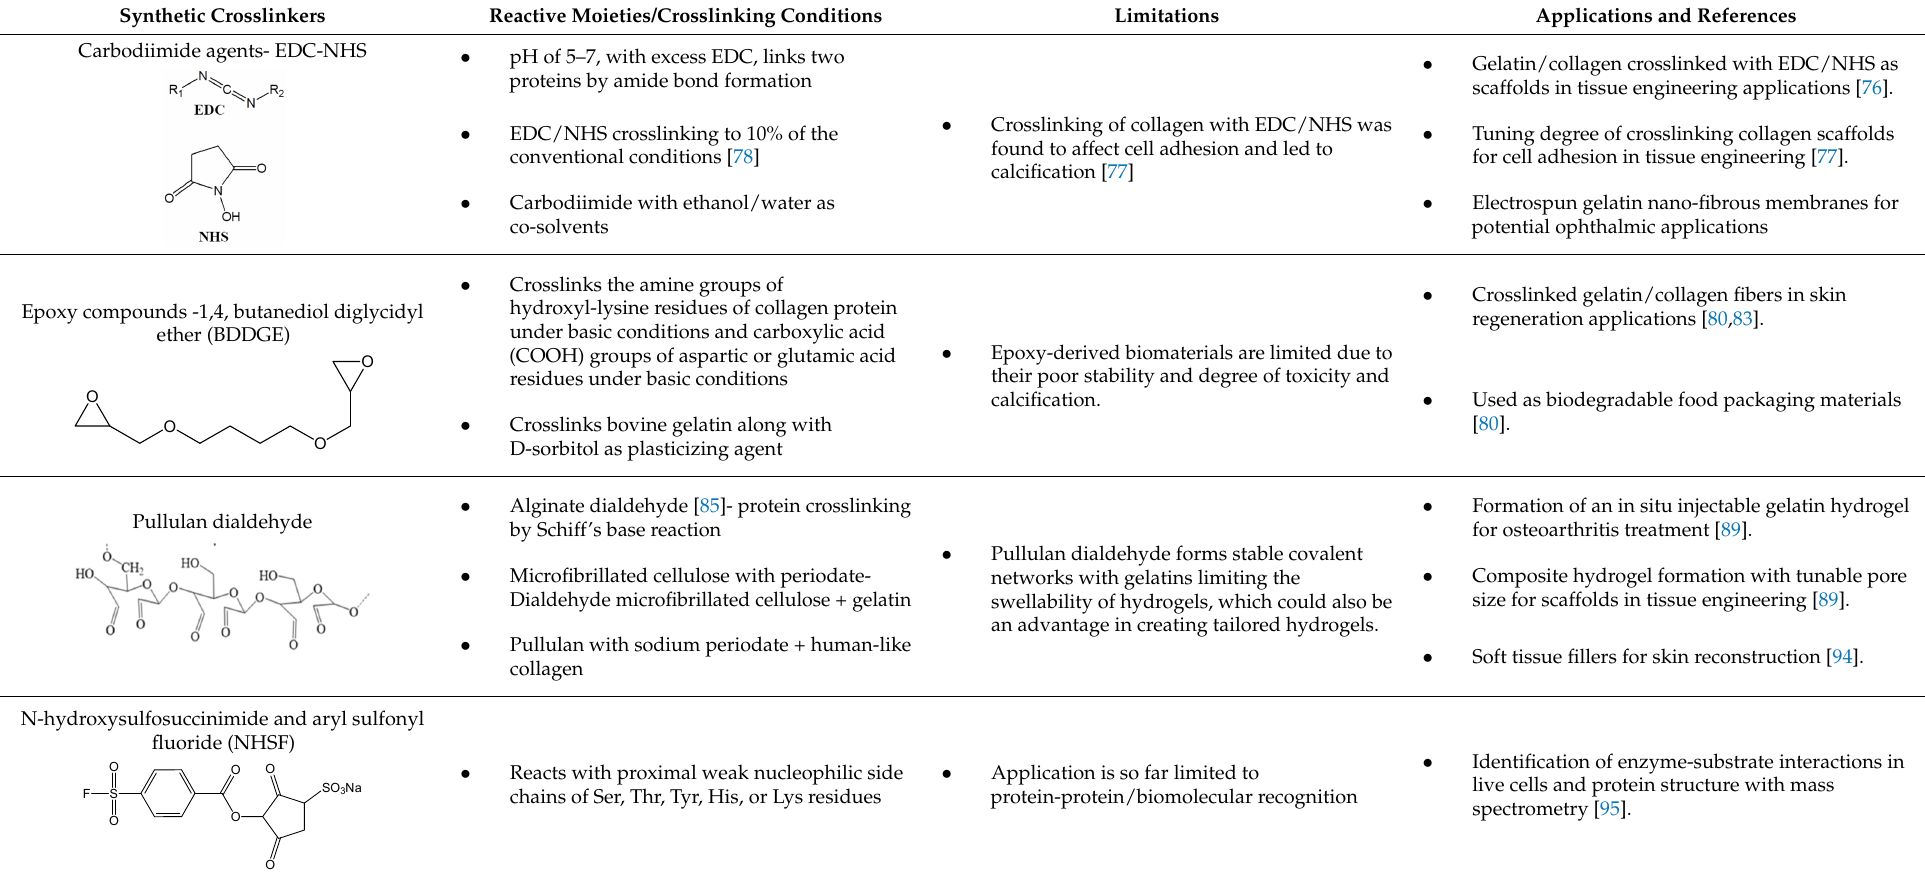
Table 2. Summary of protein crosslinking by using synthetic chemical crosslinkers.